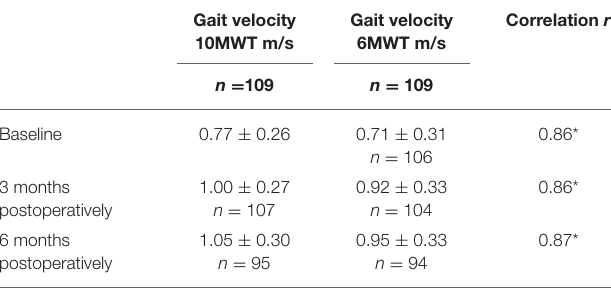
TABLE 2 | Gait velocity calculated from the 10MWT and 6MWT at baseline and 3 and 6 months